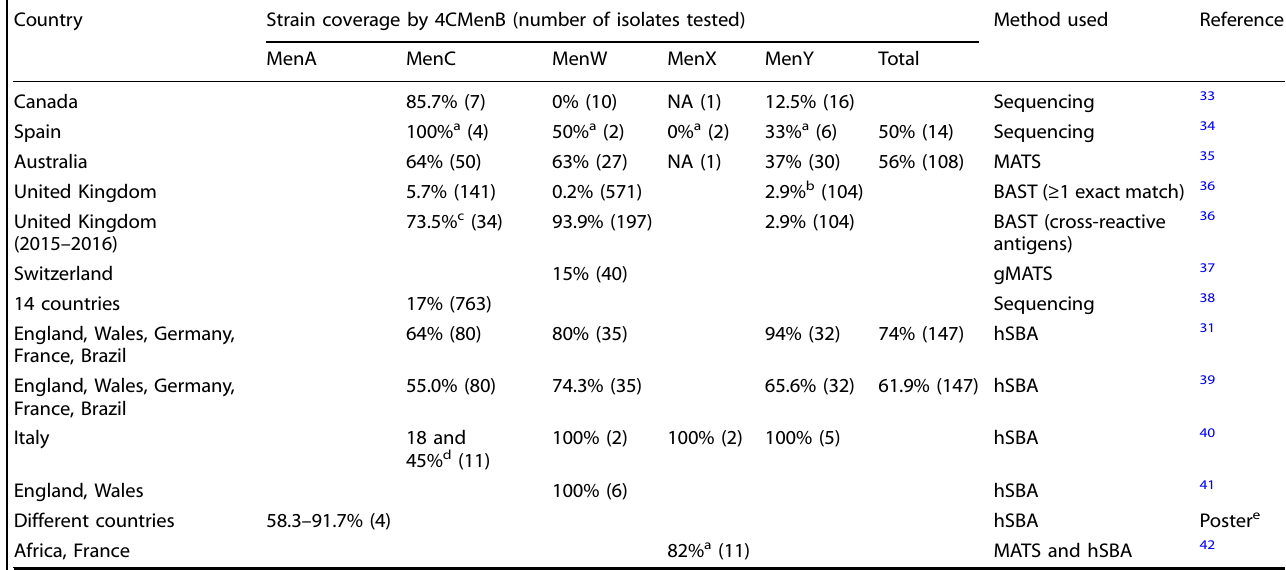
Table 1. Summary of the studies reporting (predicted) strain coverage of 4CMenB against non-B meningococcal serogroups. Country Strain coverage by 4CMenB (number of isolates tested) Method